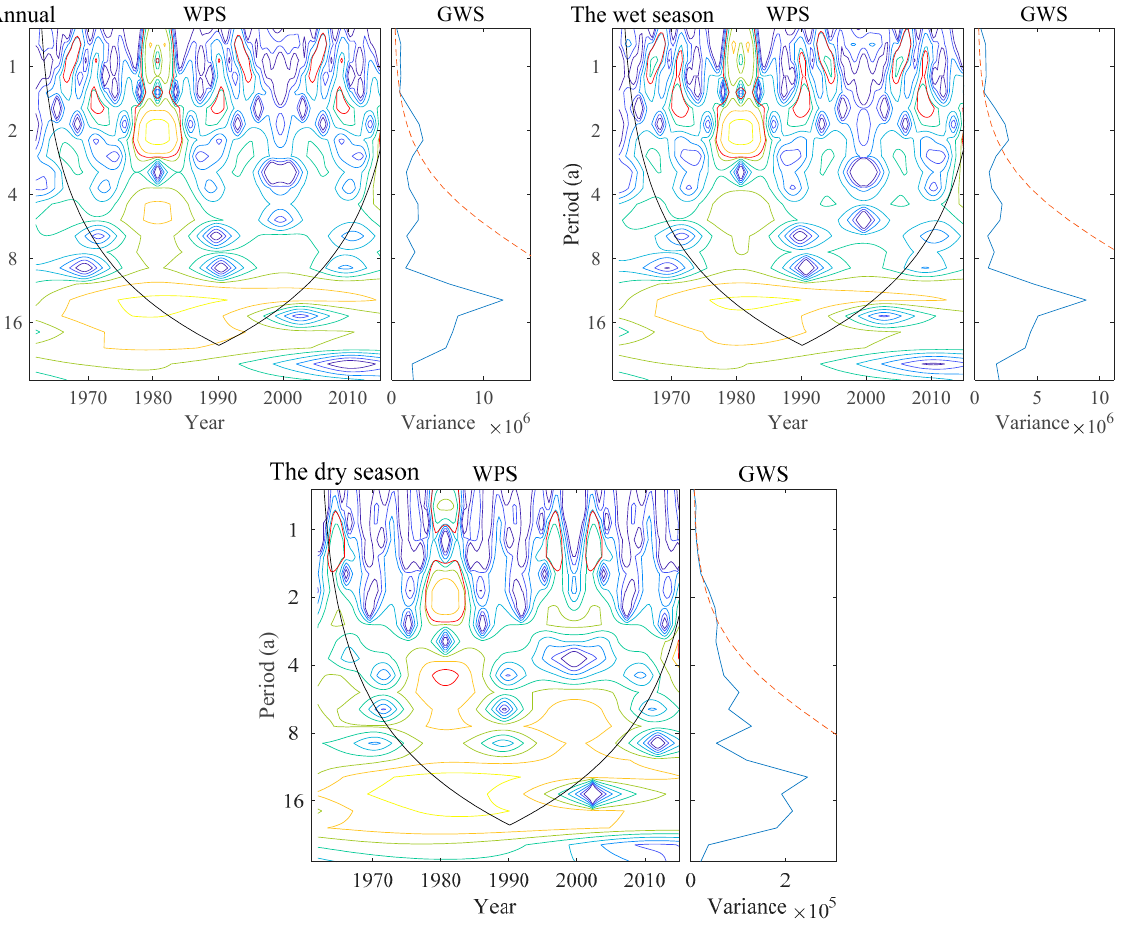
Figure 13. The runoff wavelet power spectrum and global wavelet spectrum of Daicunba station.